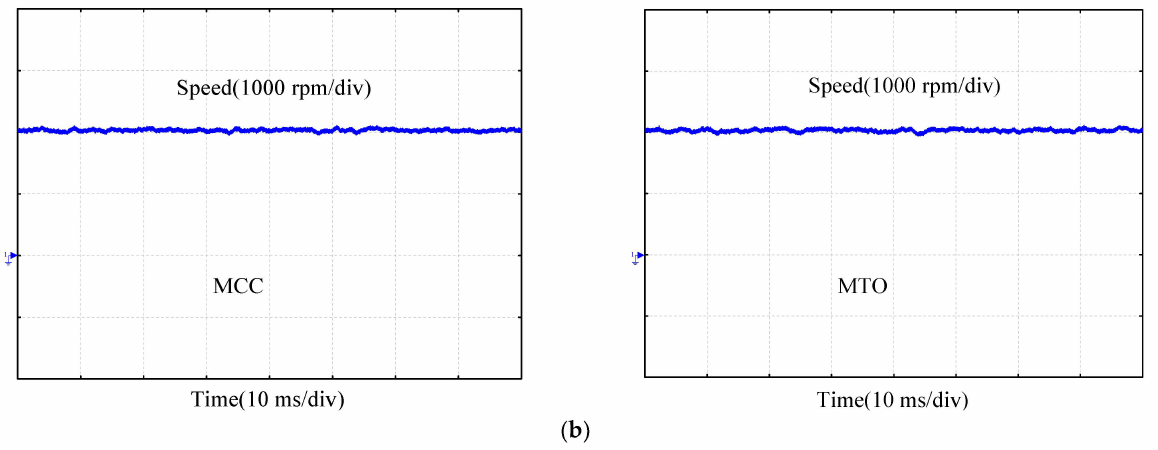
Figure 18. Motor waveform with fault-tolerant control. ( a ) Current waveform. ( b ) Speed